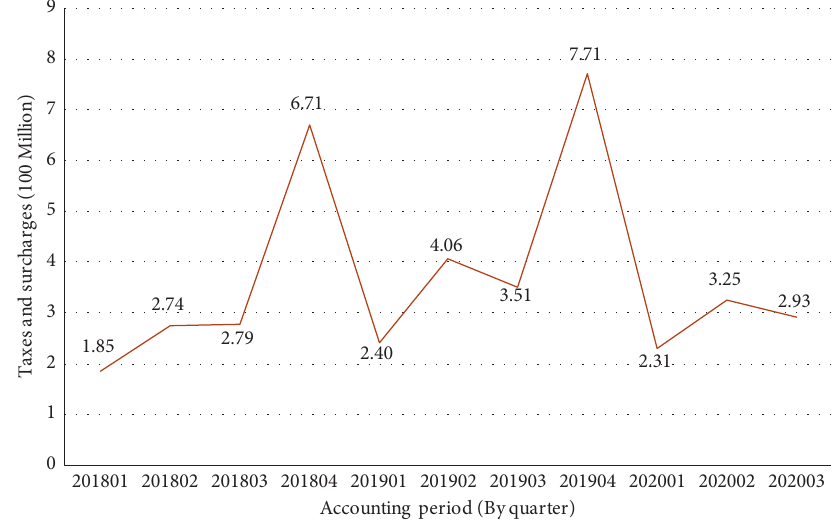
Figure 6: Taxes and surcharges changes in sample companies.